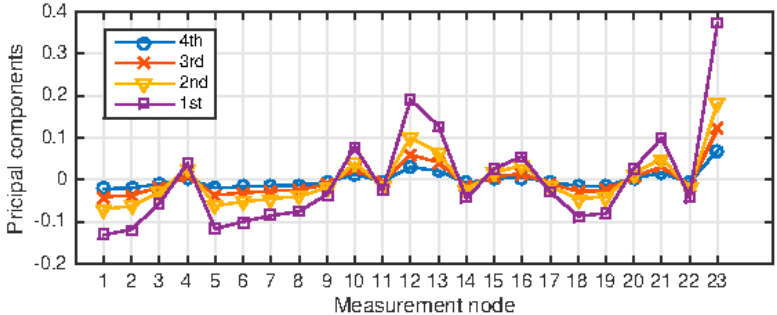
Figure 4. Principal components calculated for each measurement node.